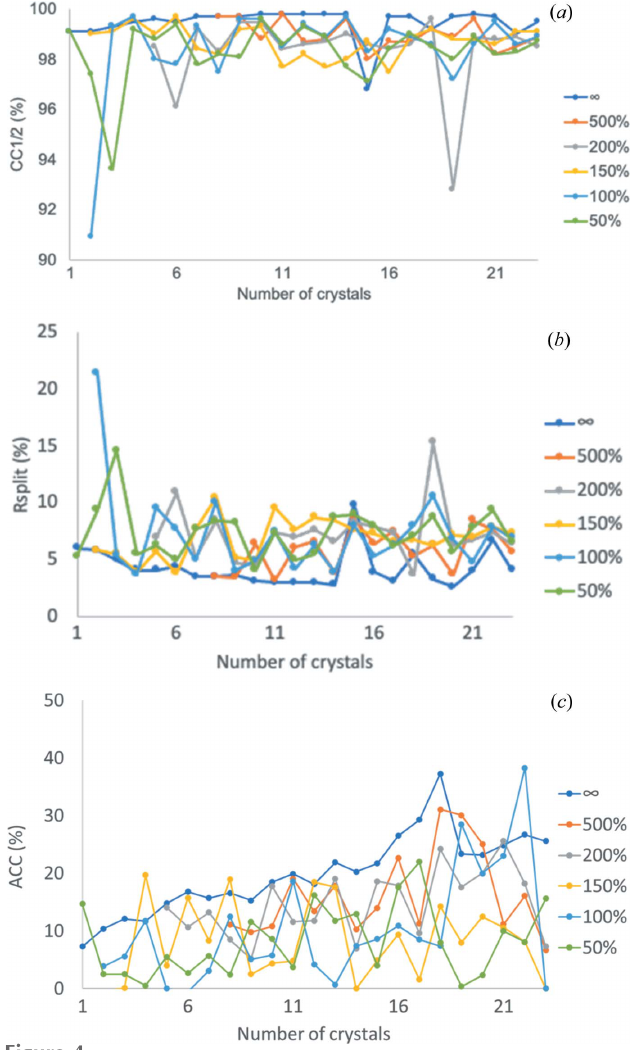
Figure 4 Data analysis of assembled TehA data. Frame rejection was performed for each assembled dataset to different extents as described in the Methods : 1 , no frame rejection and 500–50% where 50% is the most stringent rejection. ( a ) CC 1/2 at 4 A˚ d min . ( b ) R split at 4 A˚ d min . ( c ) ACC at 5 A˚ d min . ACC is reported as ‘DelAnom correlation between half-sets’ in the AIMLESS log